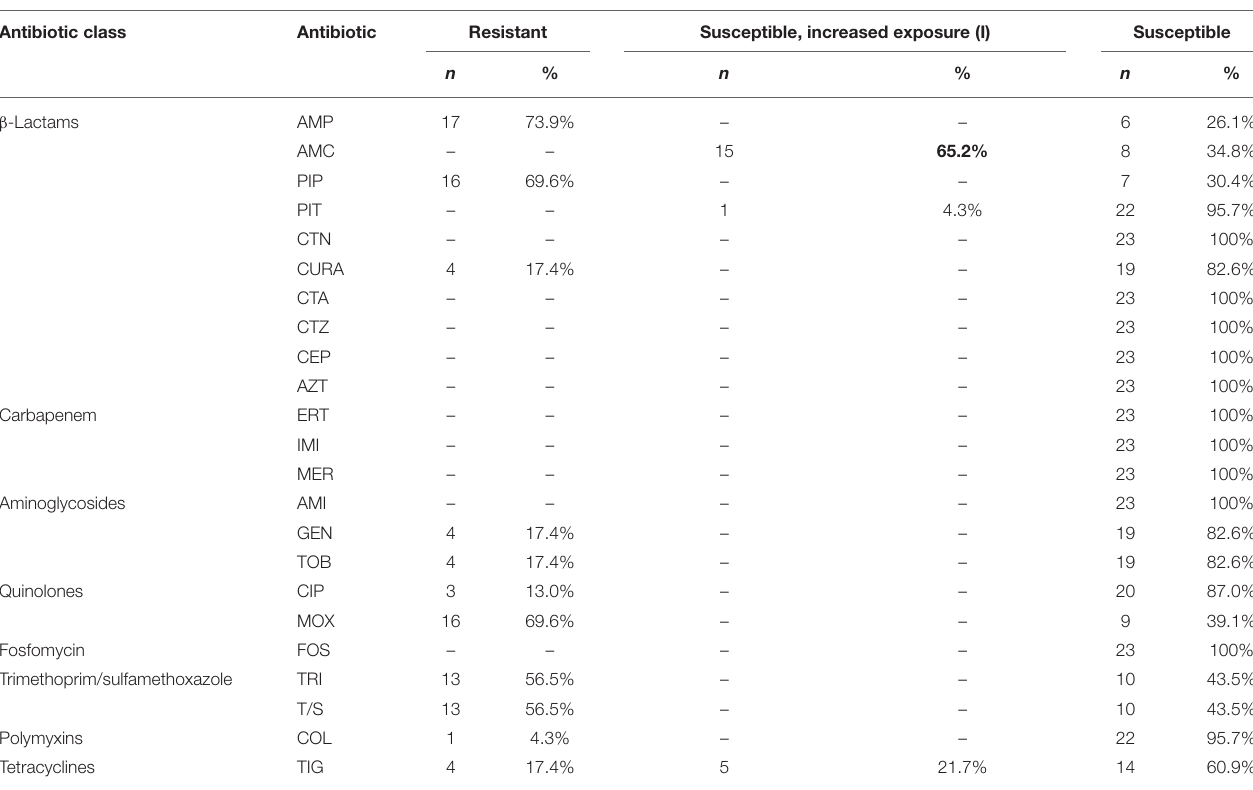
TABLE 2 | AST results of the 23 Salmonella isolates. Antibiotic class